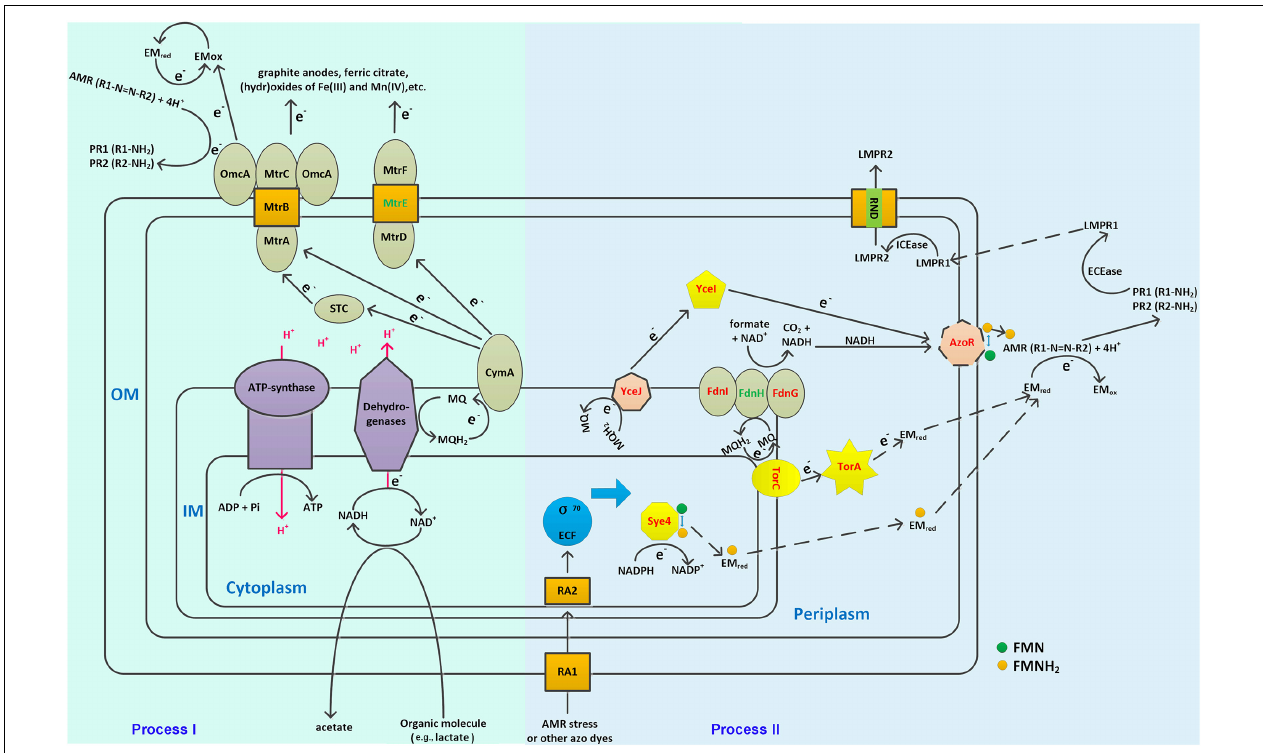
FIGURE 6 | Schematic cellular model of the novel identified azo dye degradation pathway in S. decolorationis . OM, IM, MQ, EMred, EMox, ECEase, ICEase, LMPR1, LMP2, RA1, and RA2 represent outer membrane, inner membrane, menaquinone, electron mediator in the reduced state, electron mediator in the oxidized state, extracellular enzymes, intracellular enzymes, low-molecular product-1, low-molecular product-2, stress response protein-1, and stress response protein-2, respectively. Proteins colored in red are key components in the hypothesized azo dye biodegradation models. Proteins colored in green are those not identified in the Ni1-3 genome. The solid arrows represent reactions or electron transfer pathways that have been determined previously. The dotted arrows represent reactions or electron transfer pathways hypothesized in this study.